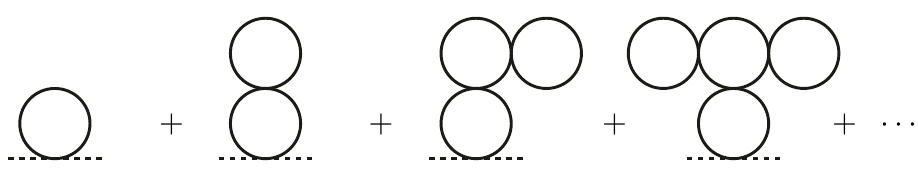
Figure 1 . The 2PI Hartree approximation. The sum in the above is included in the solution for the mode via (3.1) and is to be understood to consist of all graphs that can be formed by successive insertions of a